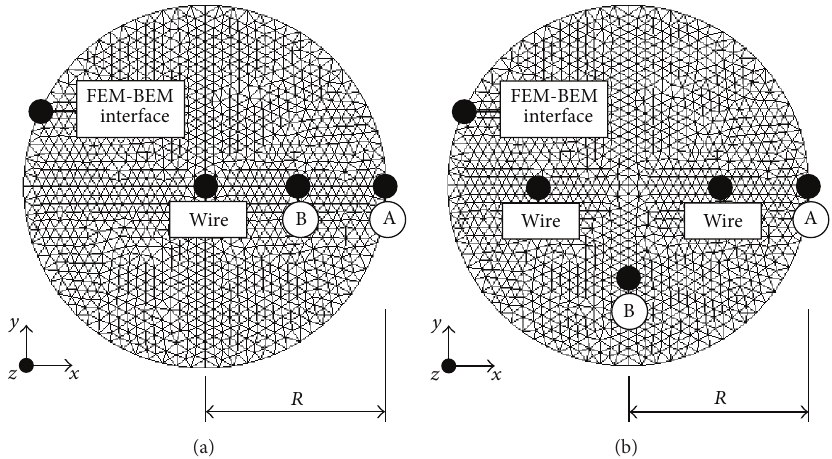
Figure 3: Sketch of the electromagnetic models and adopted FEM/BEM spatial discretizations: (a) case 1, one wire; (b) case 2, two wires.